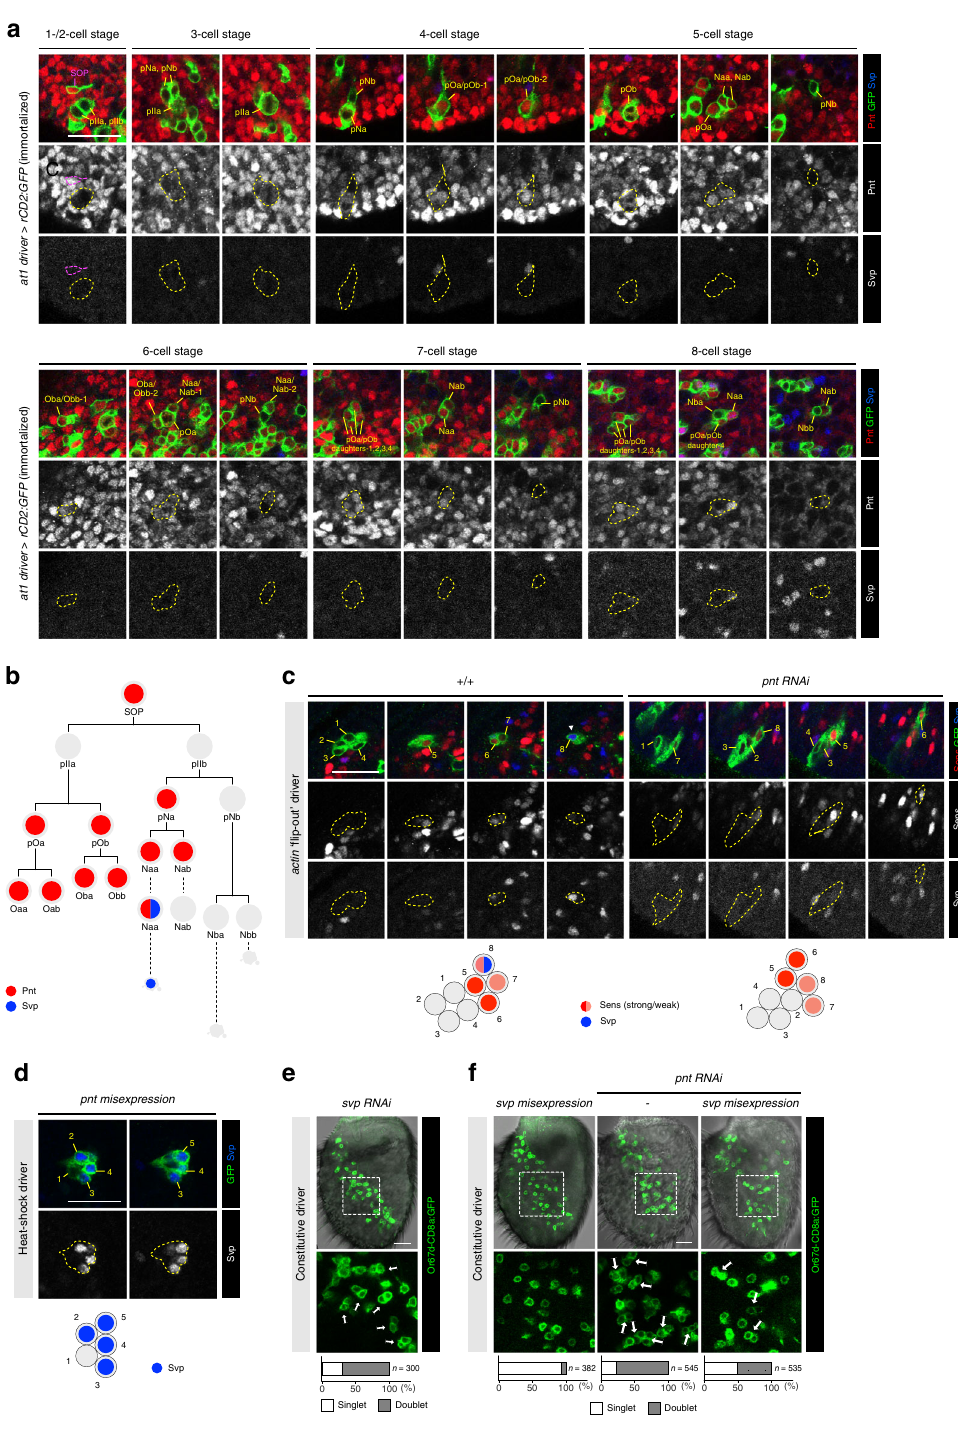
Fig. 8 Pnt is dynamically expressed in the at1 lineage and required for Svp expression. a Expression pro fi les of Pnt (red) and Svp (blue) in at1 lineages visualized with the immortalized at1 driver (green). Scale bar = 20 µ m in this and other panels. b Schematic summarizing the expression of Pnt and Svp in the at1 lineage. c Left: representative control 8-cell heat-shock clone (green) that shows the typical expression pro fi le of the at1 lineage: two cells with stronger Sens expression (red) and two cells with weaker Sens expression, one of which co-expresses Svp (blue) (see Fig. 5b, c). Right: in a representative eight-cell pnt RNAi clone (green), Sens expression (red) is unaffected but Svp expression (blue) is absent. Schematics summarizing the expression of the markers in these clones are shown below the images. d Misexpression of Pnt in a fi ve-cell clone (green) induces ectopic Svp expression (blue) in four of the cells. (Clones do not develop beyond this stage.) e svp RNAi antennae expressing the Or67d -CD8a:GFP reporter exhibit a large fraction of doublets of GFP-positive neurons (green). f Misexpression of svp alone (left) does not affect the normal speci fi cation of Or67d -CD8a:GFP-labeled OSNs. Two independently constructed UAS-svp transgenes were used in this experiment: UAS-svp.II (shown in this panel) and UAS-svp1 . Misexpression of svp in the pnt RNAi background reduces the fraction of OSN doublets (middle and